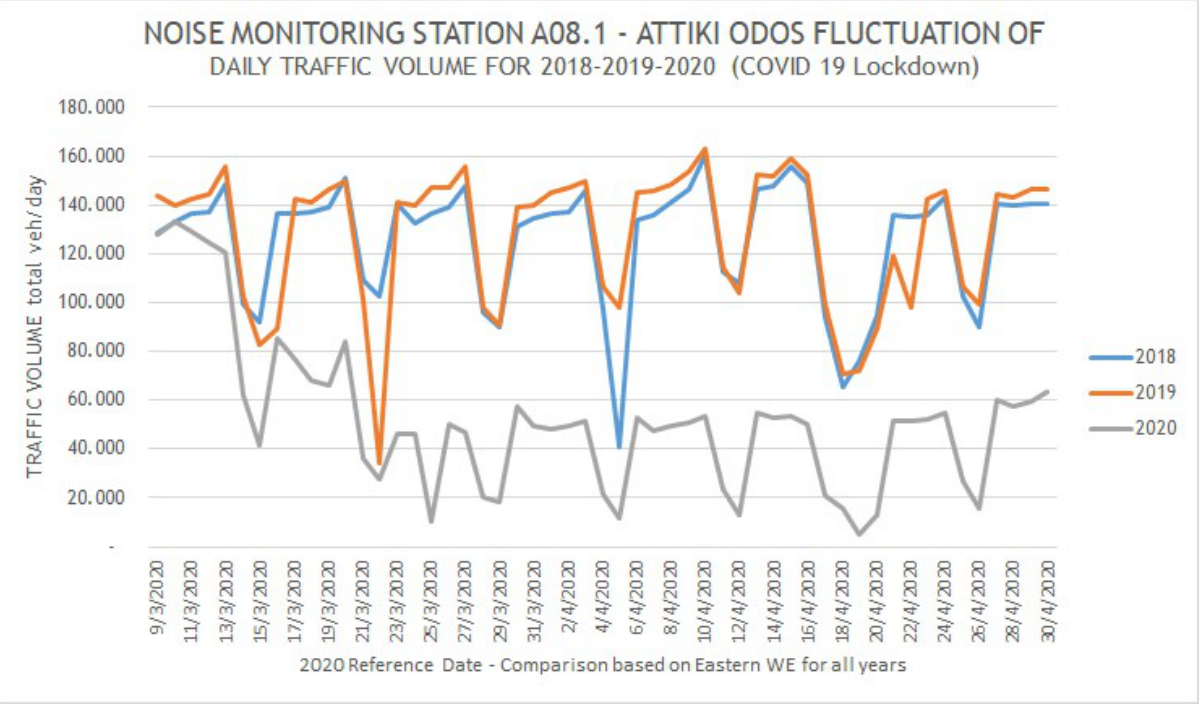
Figure 8b: Daily traflc volume – Noise monitoring station